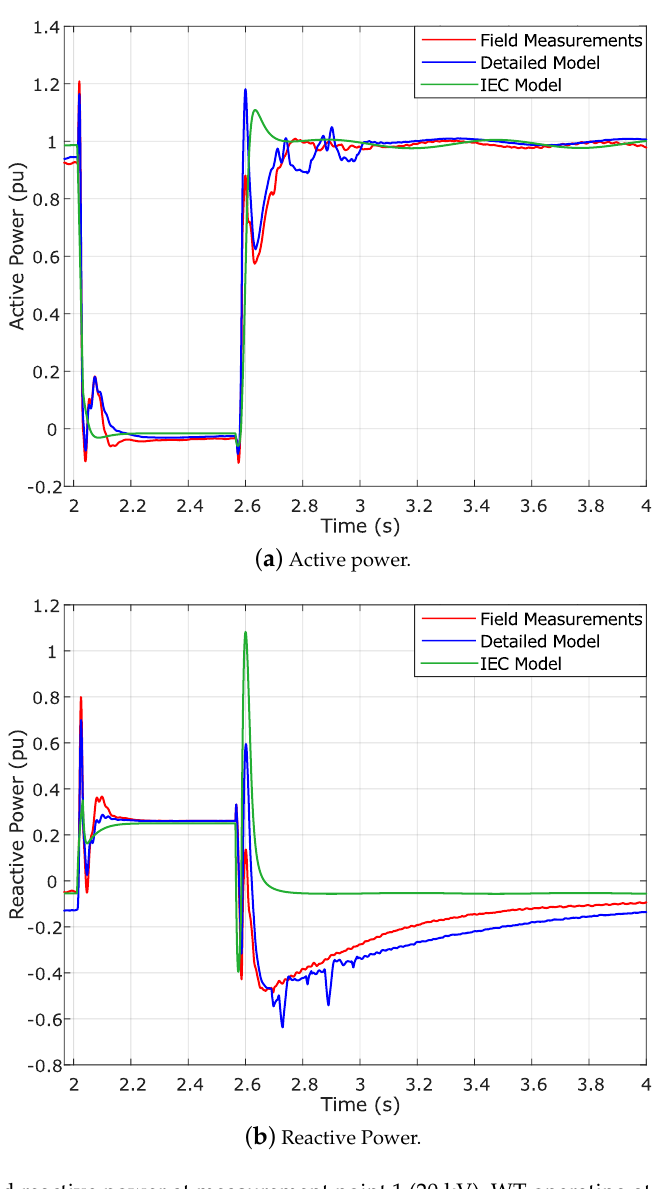
Figure 5. Active and reactive power at measurement point 1 (20 kV). WT operating at full load